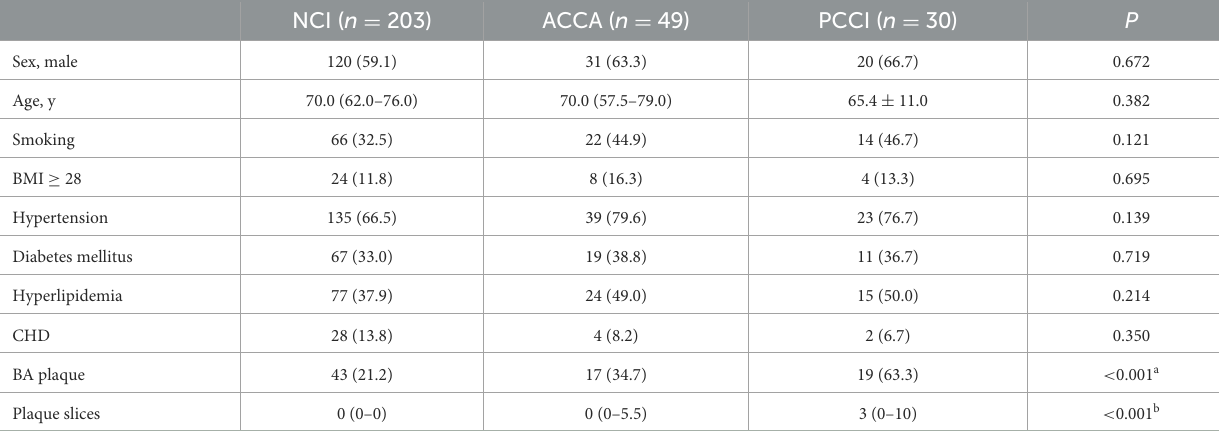
TABLE 1 Association between the BA plaque and cerebral infarction.